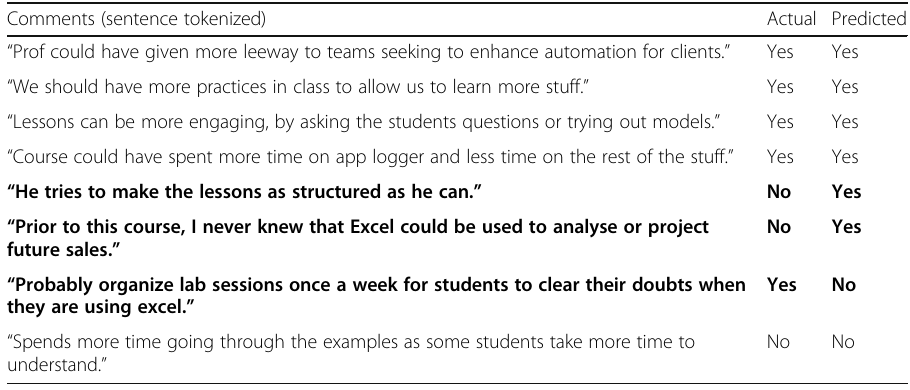
Table 8 Sample comments from the dataset and the predictions by the tool as suggestions (Yes) or not (No). Bolded are incorrectly predicted comments Comments (sentence tokenized) Actual Predicted